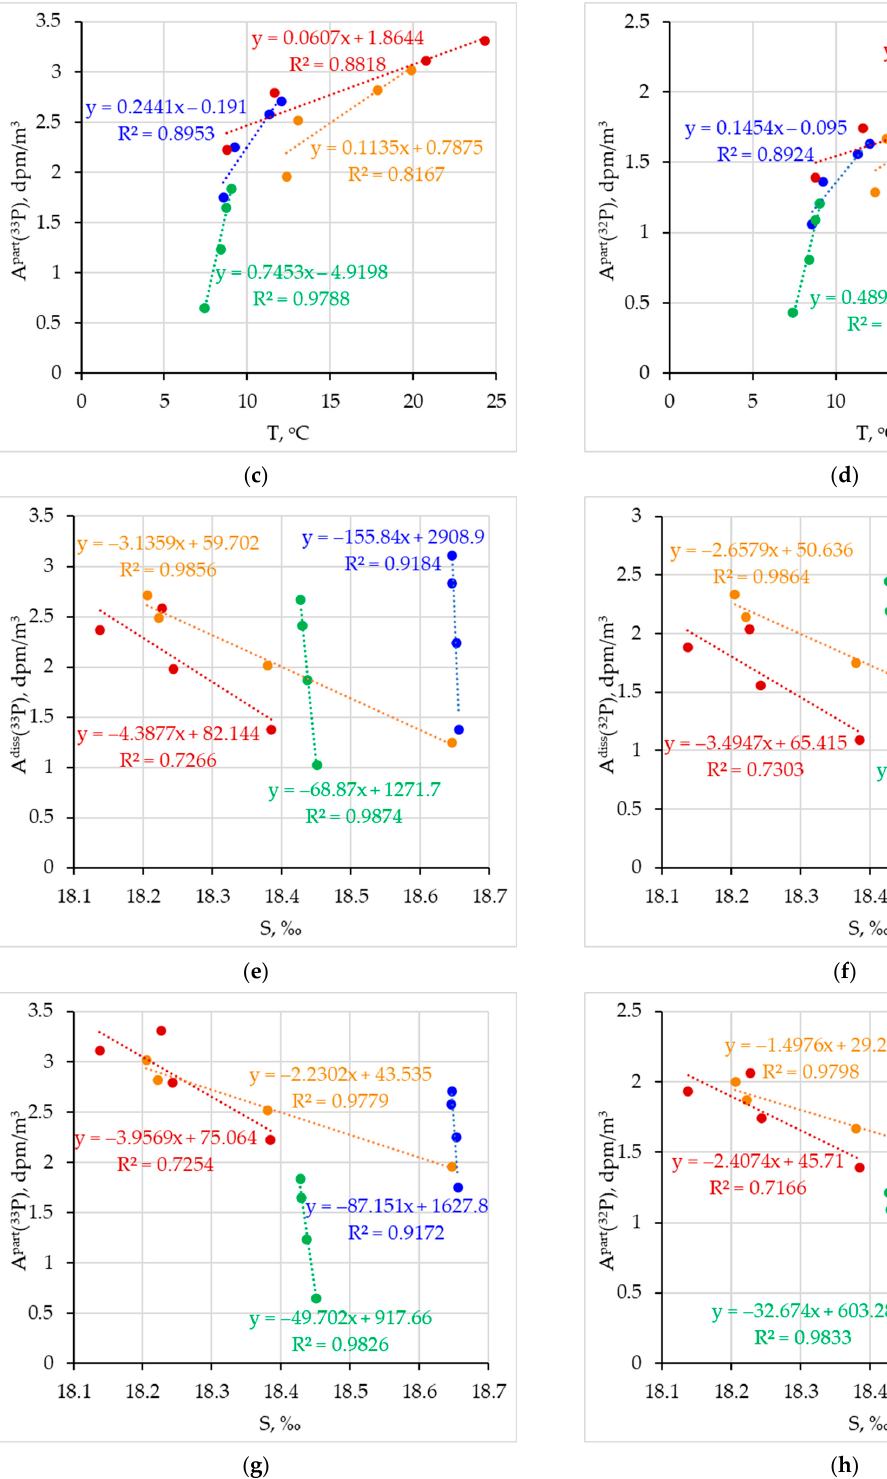
Figure 7. Dependences of 33 P ( a , c , e , g ) and 32 P ( b , d , f , h ) volumetric activity in dissolved ( a , b , e , f ) and particulate ( c , d , g , h ) form on temperature ( a – d ) and salinity ( e – h ) (winter 2021 ( • ), spring 2022 ( • ), summer 2022 ( • ), autumn 2022( •